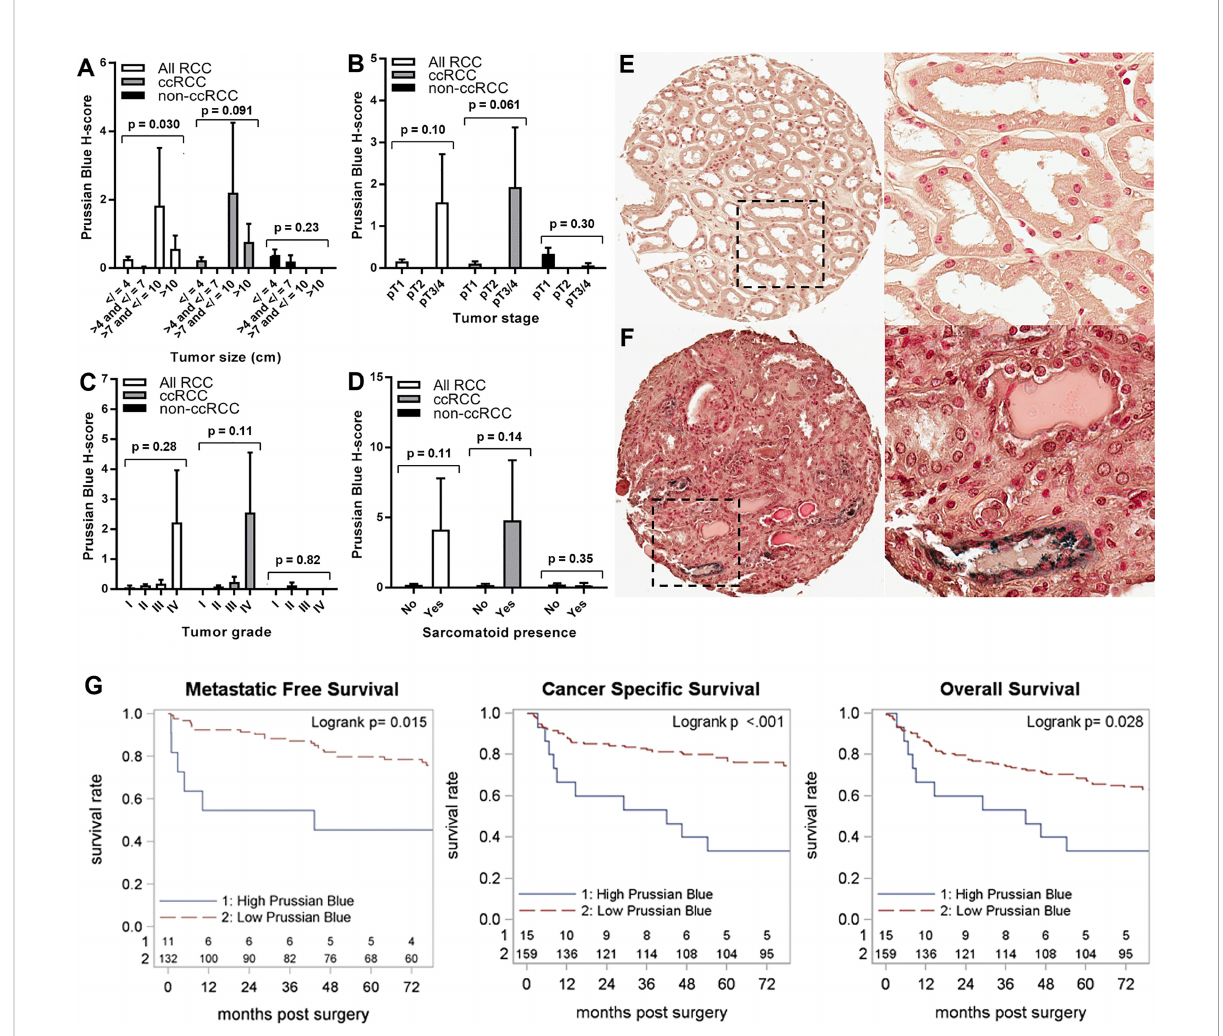
FIGURE 5 Iron levels increase in non-neoplastic kidney during tumor progression. Normal (non-neoplastic) renal tubule epithelial iron levels (H-score) were evaluated using Prussian Blue stain of the RPCCC RCC patient TMA set and tested for association with pathologic features of primary tumors including (A) tumor size (largest diameter), (B) tumor stage, (C) tumor grade, and (D) presence of sarcomatoid dedifferentiation. Representative tissue core images of normal kidney tissues are shown at low magni fi cation (left) and high magni fi cation (right) for a patient with (E) low grade RCC and a patient with